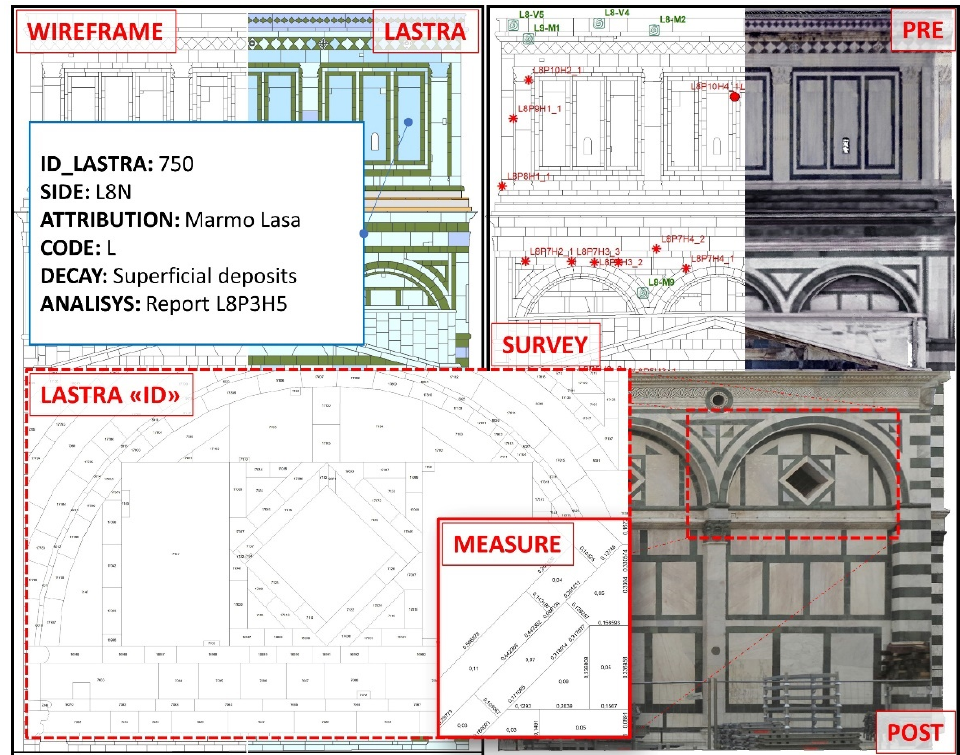
Figure 2. Composition showing the possibilities of extracting information from the database within a GIS system: Wireframe view, coatings selection (LASTRA), showing ID_LASTRA, SIDE, STTRIBUTION LITHOLOGY, CODE, DECAY, and the existence of a laboratory analysis. From the system, it is also possible to view the dimensions of each single element and the photo planes.